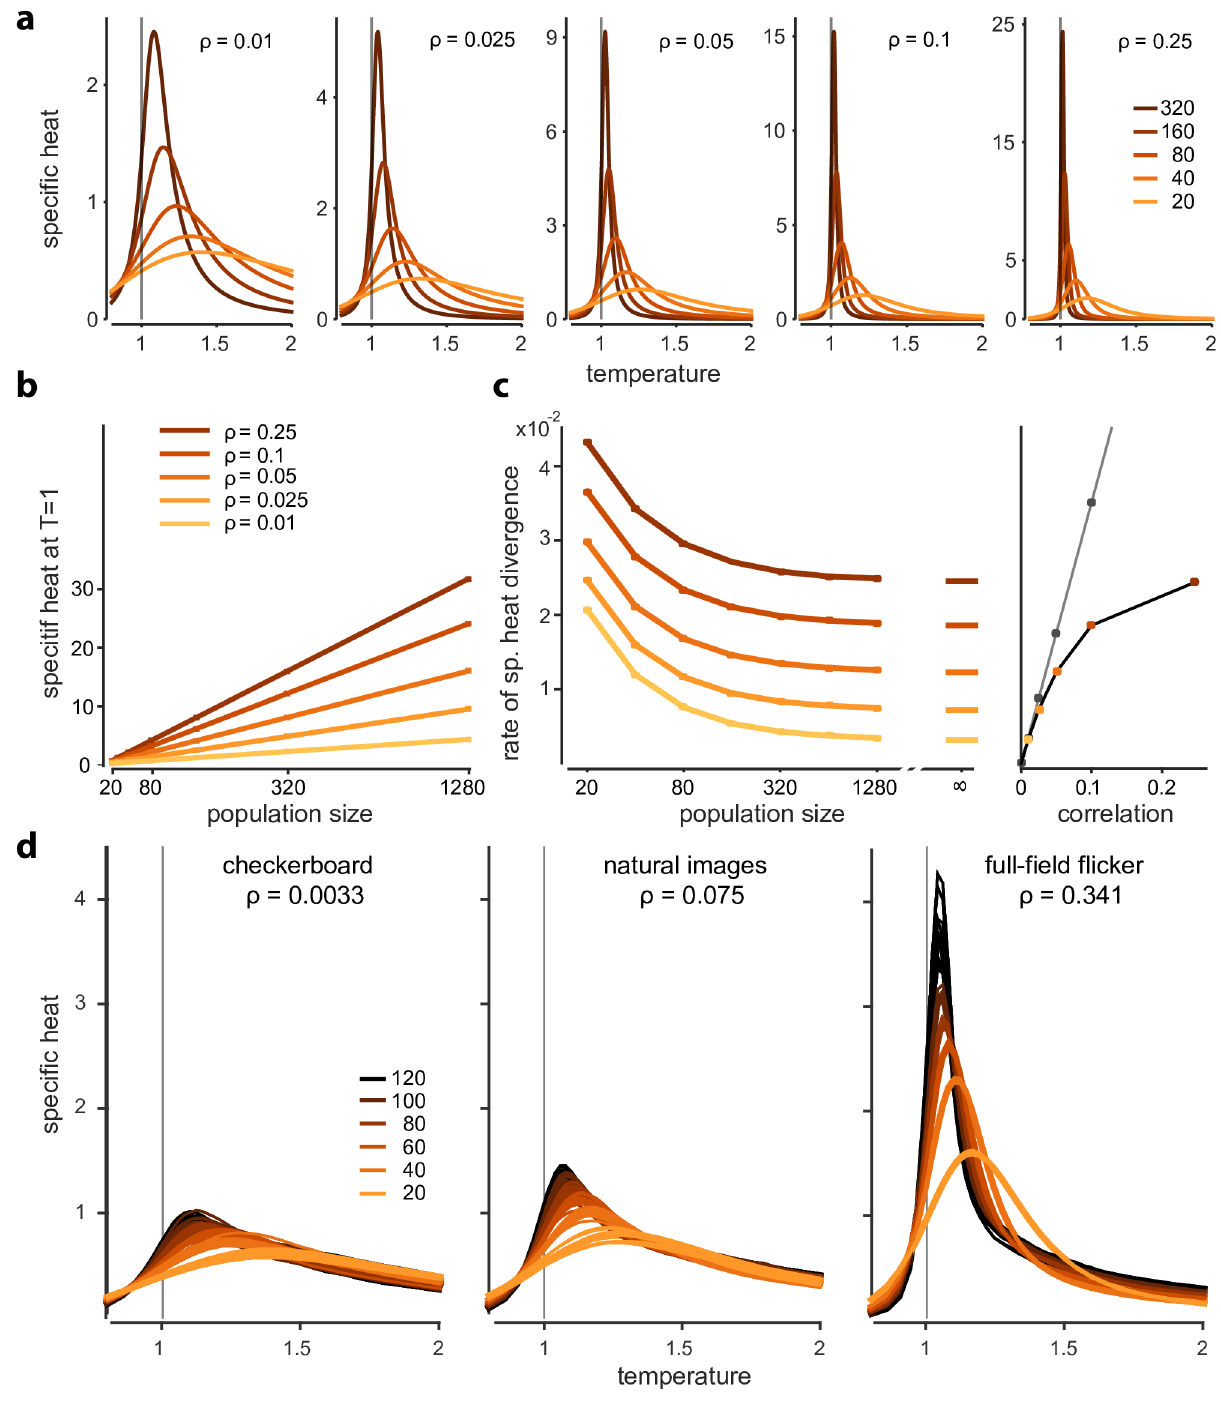
Fig 4. Relationship between correlations and criticality. a) Specific heat traces for beta-binomial model, different correlation strengths and populationsizes. Heat traces are qualitativelysimilar, but differ markedly quantitatively (see y-axes). b) Specific heat divergeslinearly, and the slope depends on the strength of correlations. c) Divergencerate of specific heat for beta-binomialmodel as a function of correlation strength (left). Rightmost point (at infinity) correspondsto analyticalpredictionof large- n behaviour.Divergence rates are strictly increasing with correlation strength (right) which is capturedby a weak-correlation approximation (dashedline). d) Specific heat increaseswith correlationin the K-pairwise maximum entropy model: averageand individualtraces for 10 randomly subsampledpopulations for 6 different populationsizes. Left to right: checkerboard, natural images and full-fieldflicker stimuli presented to the population. Correlationstrengths denote mean correlationcoefficient in each population.